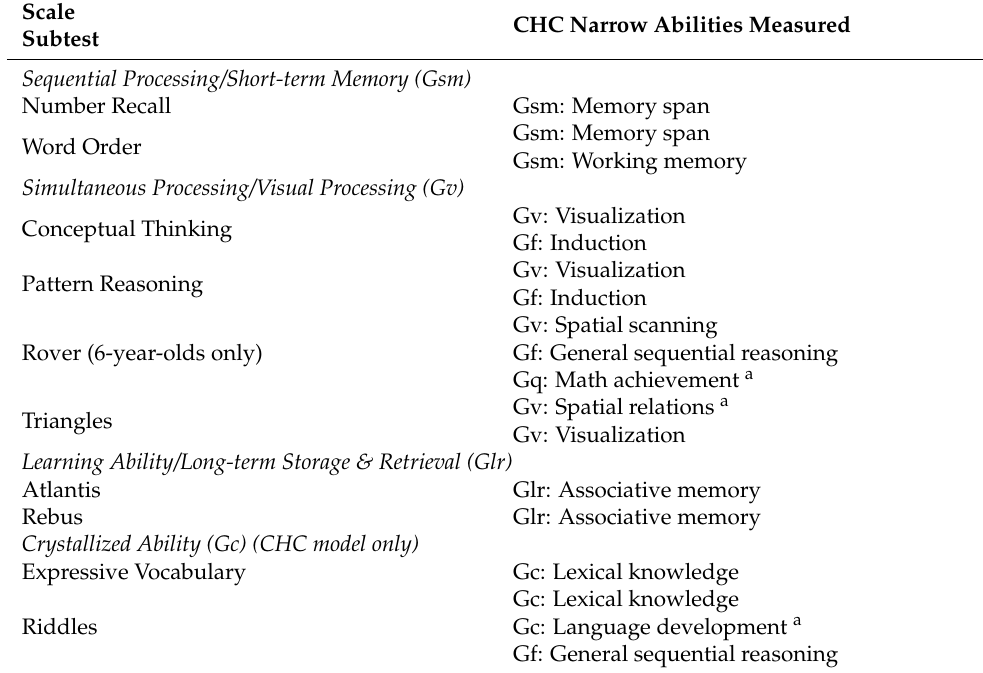
Table 1. KABC-II scales and core subtests for 5- and